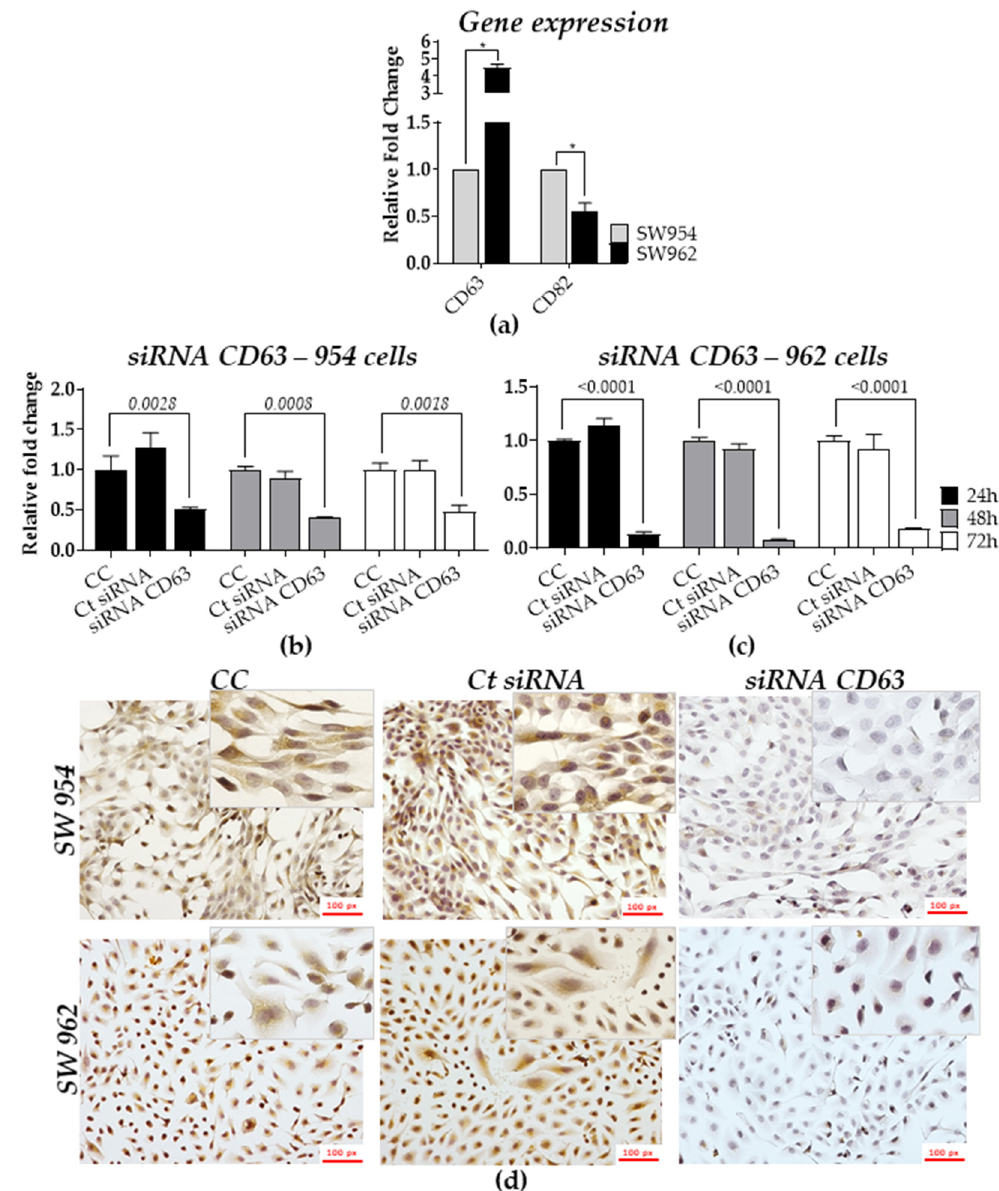
Figure 4. In vitro TSPANs expression in both non-metastatic (SW954) and metastatic (SW962) cell lines. ( a ) Basal transcript expression levels for CD63 and CD82 in SW962 cells, as compared with SW954 (RQ = 1). Expression values were determined after normalization with β 2 microglobulin (B2M); relative expression of CD63 in SW954 ( b ) and in SW962 ( c ) cells 24, 48, and 72 h after CD63-siRNA transfection; ( d ) CD63 protein expression assessment by ICC (scale bars, 100 px) 48 h after cells transfection. Results were plotted as mean values ± standard deviation (SD). * p < 0.05. CC: Non-transfected cells,